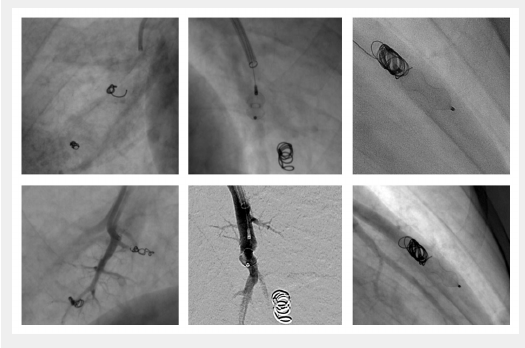
Examples of pulmonary arteriovenous malformation endovascular vaso-occlusions with vascular coils, plugs and combined treatment.